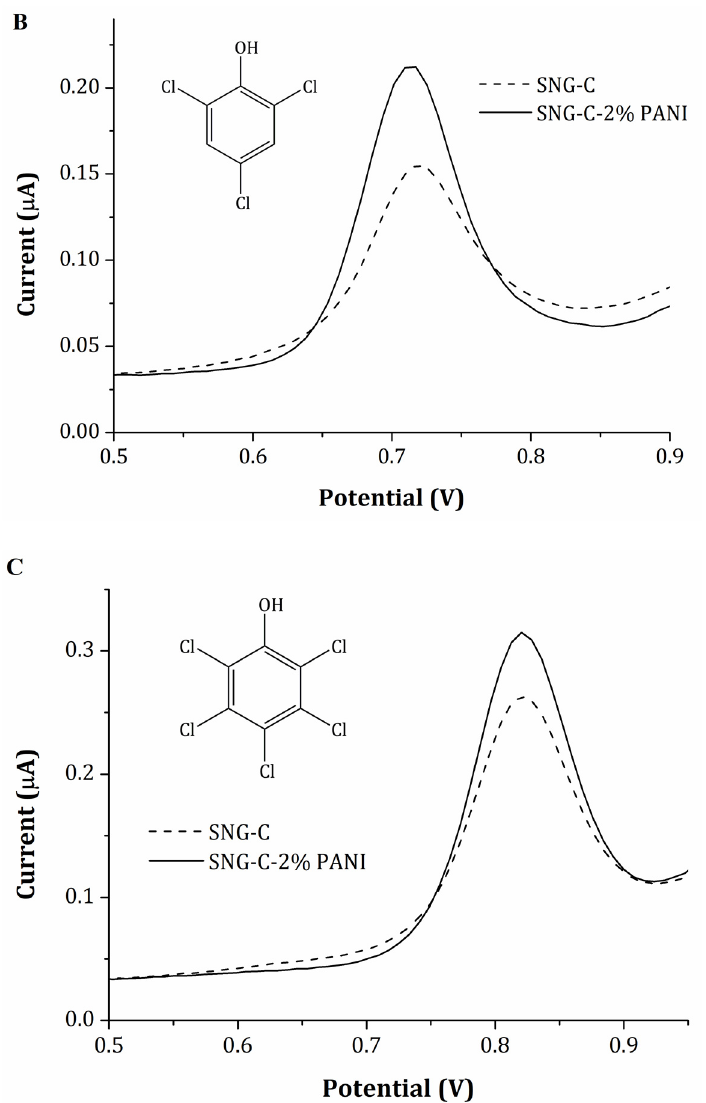
Figure 7. Differential pulse voltammograms recorded with SNG–C–2% PANI in presence of 7 µ M of different chlorophenols: ( A ) 2-chlorophenol (2-CP), ( B ) 2,4,6-trichlorophenol (TCP) and ( C ) pen-tachlorophenol (PCP). A buffer solution containing 0.1 M acetic/acetate with 0.5 M KCl at pH 4 was used as electrolytic medium.